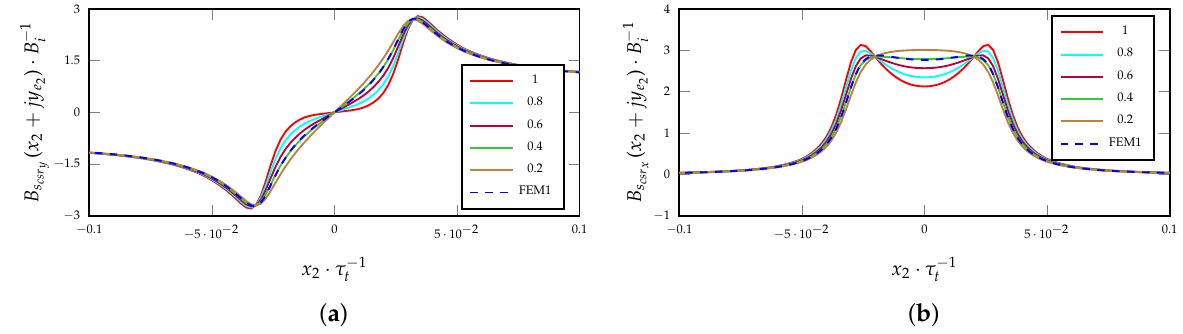
Figure 12. p.u. analytical flux density distributions of (10) on the exploration segment γ e values of k r in comparison with FEM1: ( a ) normal; ( b ) tangential components ( − τ t / 10 ≤ x 2 ≤ τ t /